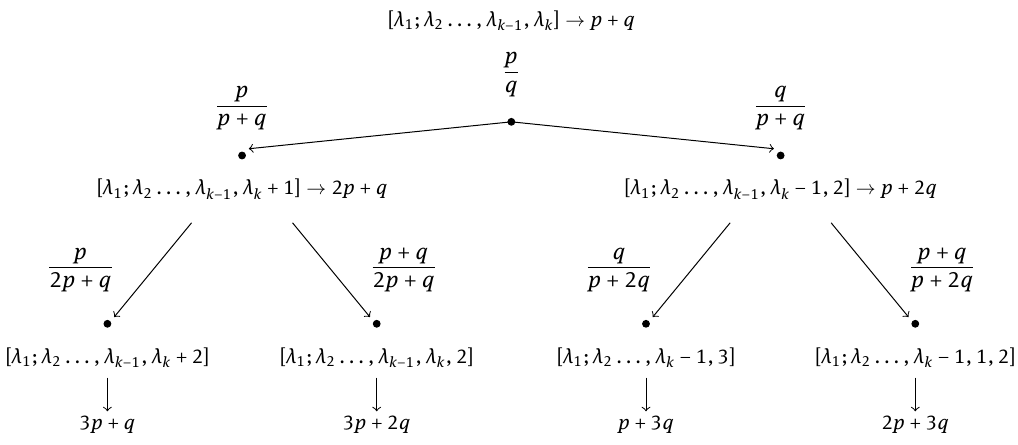
Figure 19: If parent and grandparent satisfy the statement, then so do the four